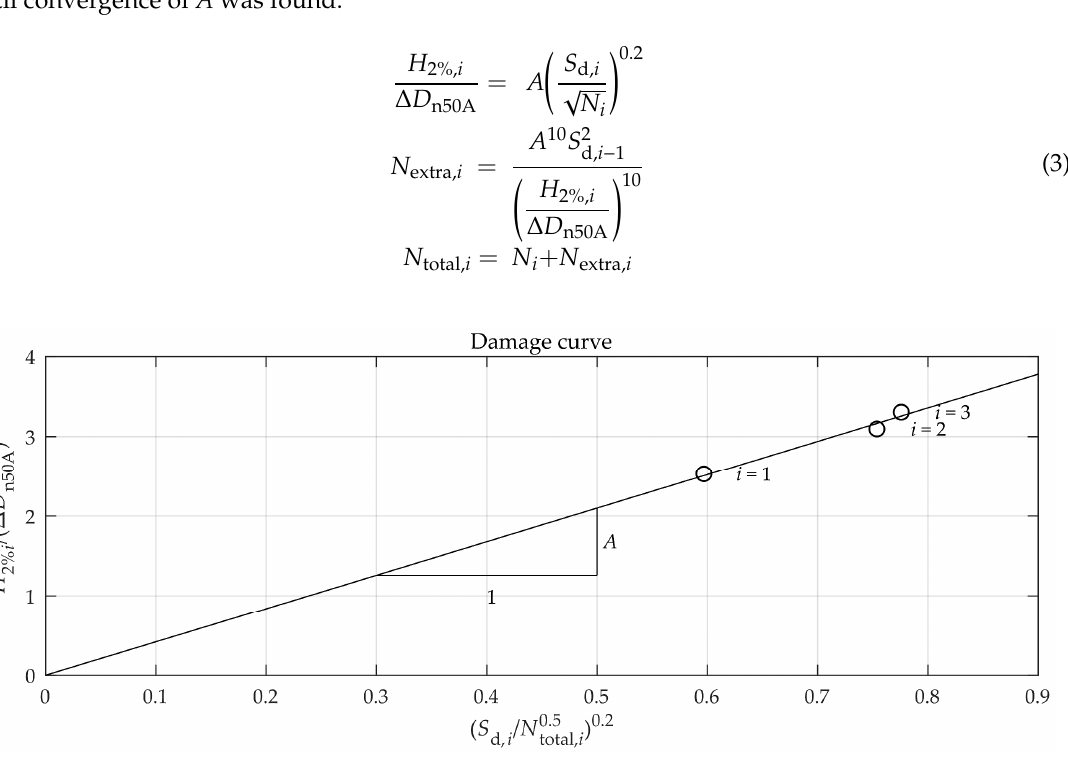
Figure 9. Damage curve for accumulated tests. The tests are shown with markers and the test number in the wave series is given by i . A and N total, i are found by iterating Equation (3) until convergence of A is